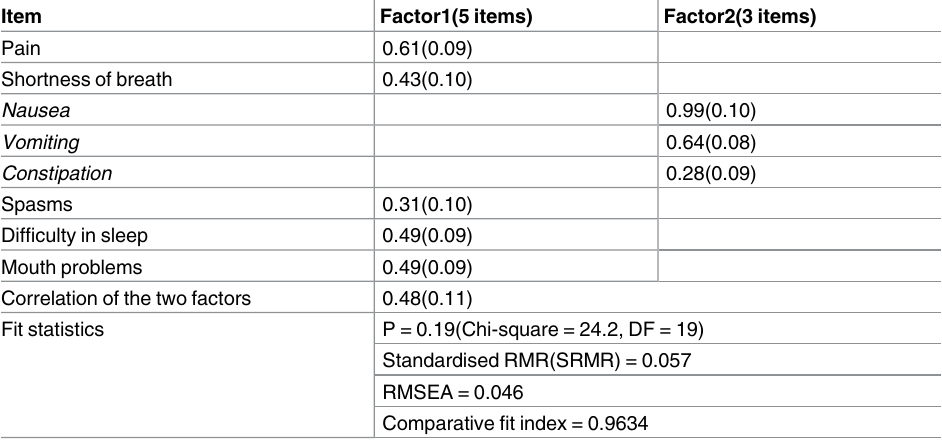
Table 3. Standardized Factor Loadings (Standard Error, SE), factor correlation (SE) and the fit indi- ces in the confirmatory factor analysis of the IPOS